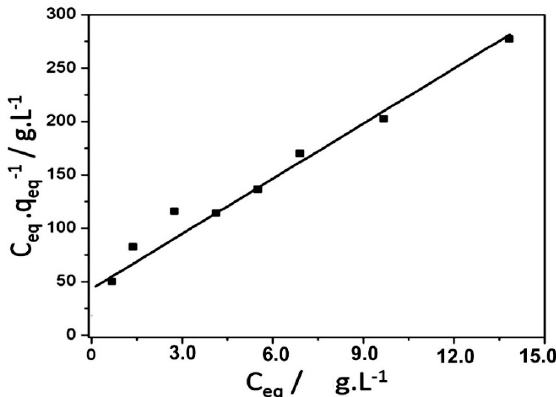
Figure 8. Linear plot of the adsorption isotherm of NP@DTPA in Nd 3+ solutions based on the Langmuir Equation (9).